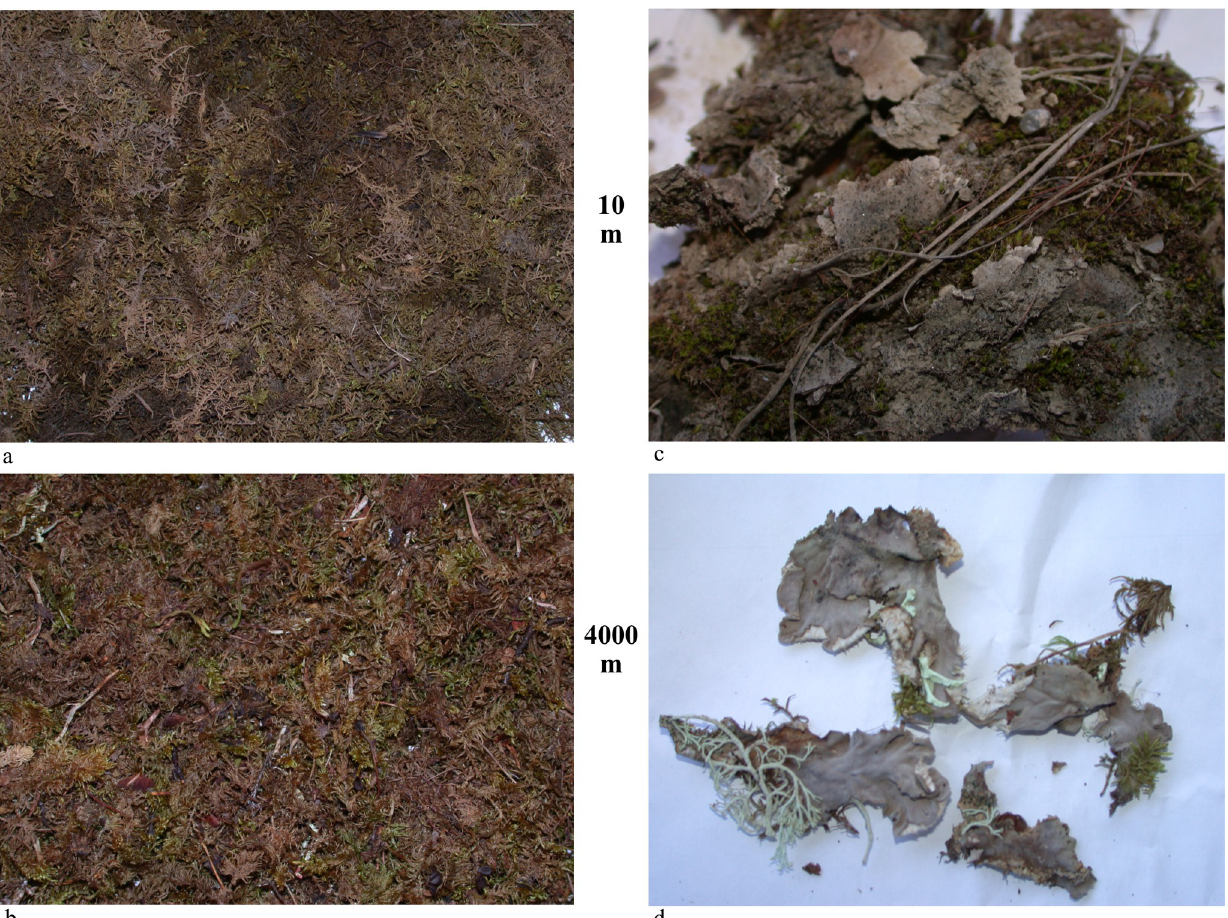
Fig 5. Photos of Hylocomium splendens moss and Peltigera sp. lichen from 10 m vs 4000 m away from the DMTS haul road in Cape Krusenstern National Monument, Alaska. Photos a, b: H . splendens . Photos c,d: Peltigera sp. Photos were taken in the lab using dried materials.